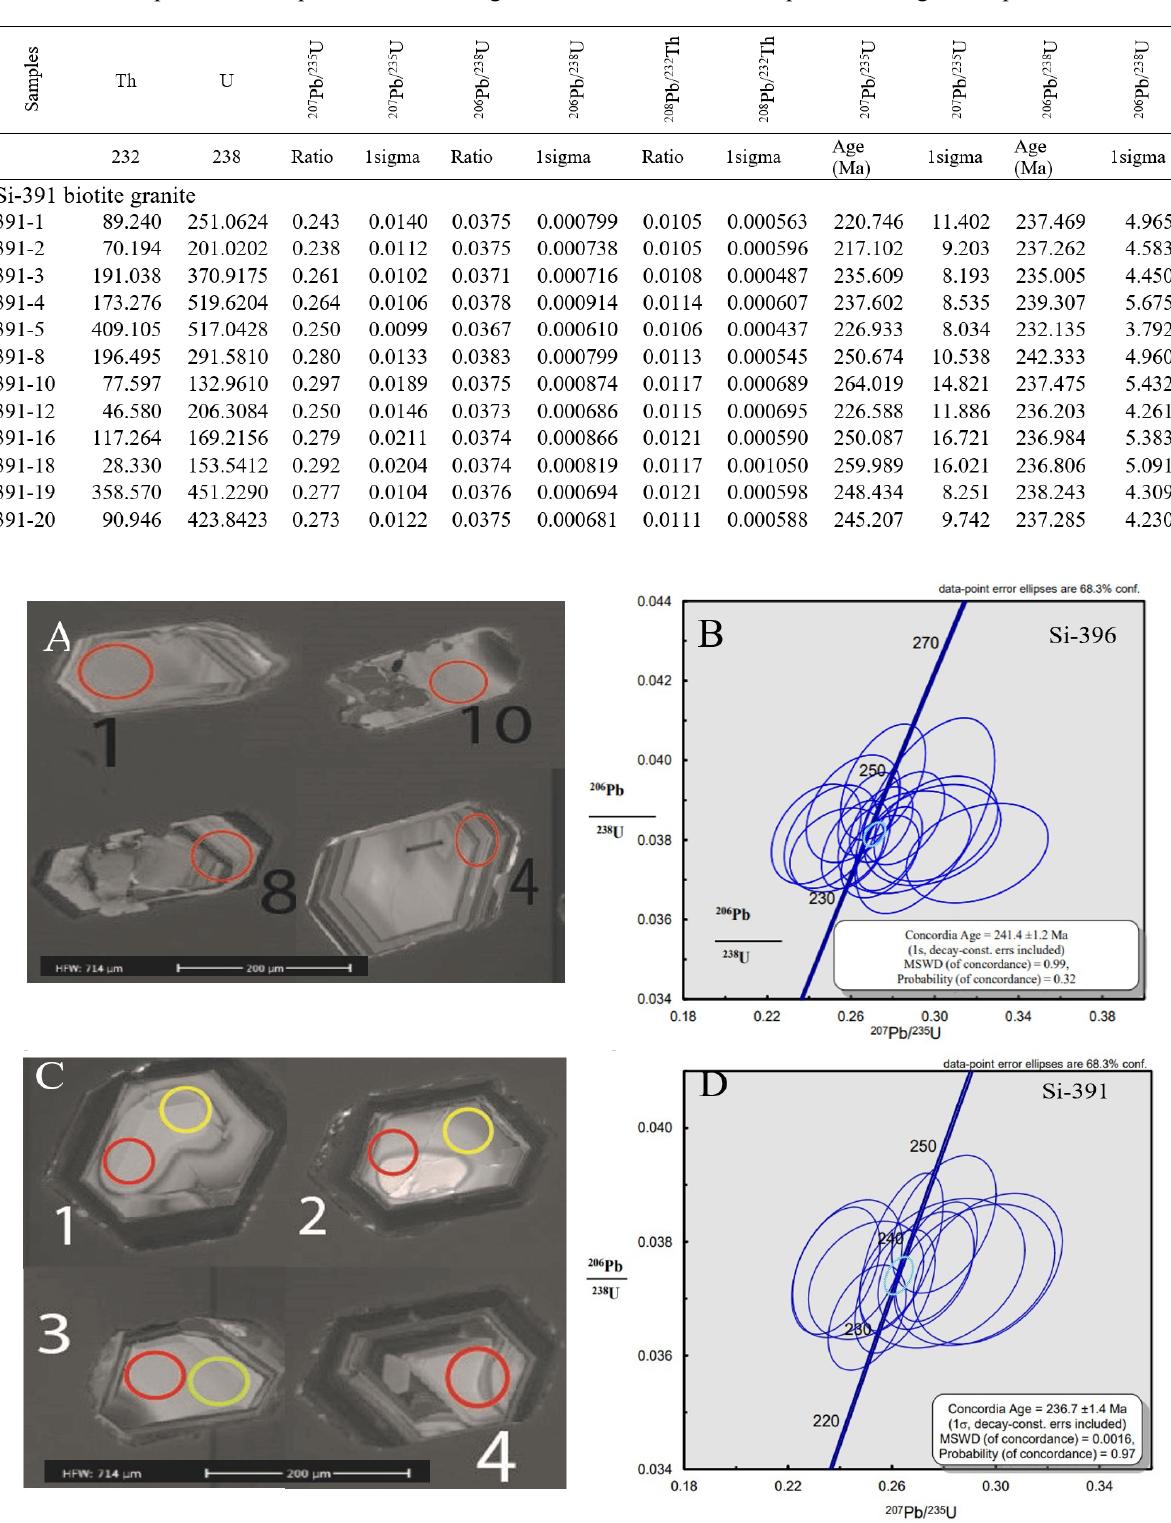
Fig 19. CL images as (a and c) and its concordia diagram (b and d) of the Taatsiin Gol pluton, Khangai